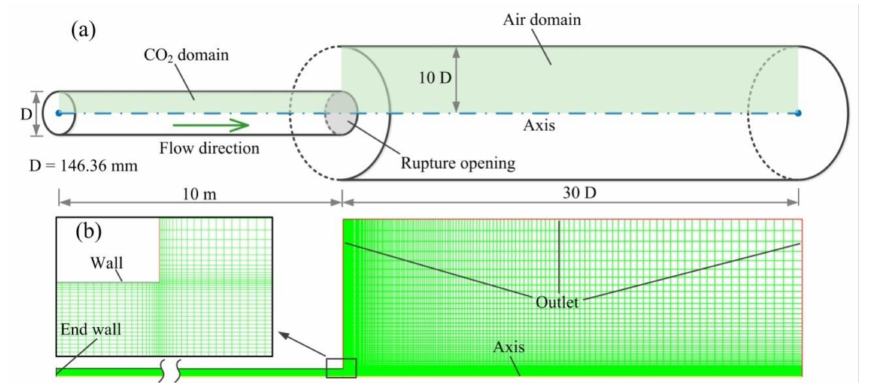
Figure 1. Schematic diagram of ( a ) computational domain and ( b ) computational meshes. The meshes around the wall and rupture openings have been